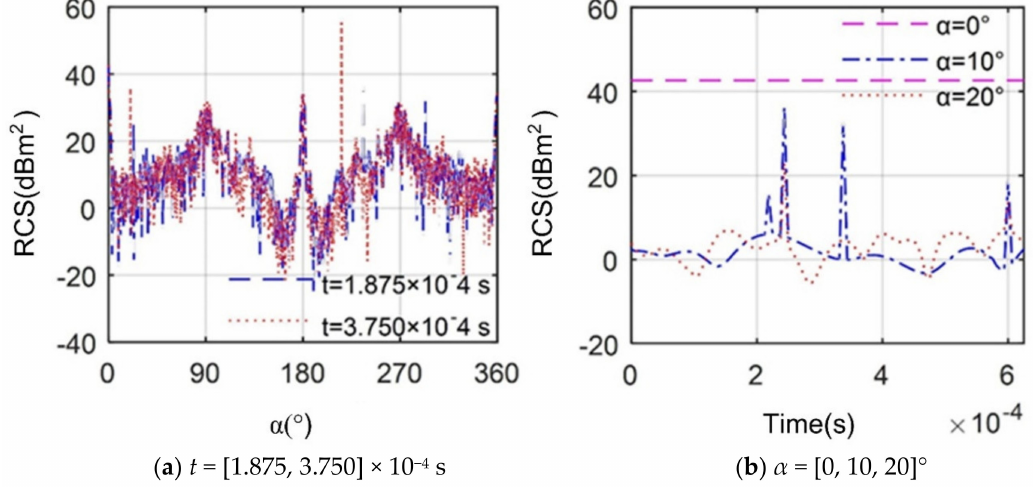
Figure 15. The dynamic RCS of m engine , N obs = 1 and β = 0 ◦